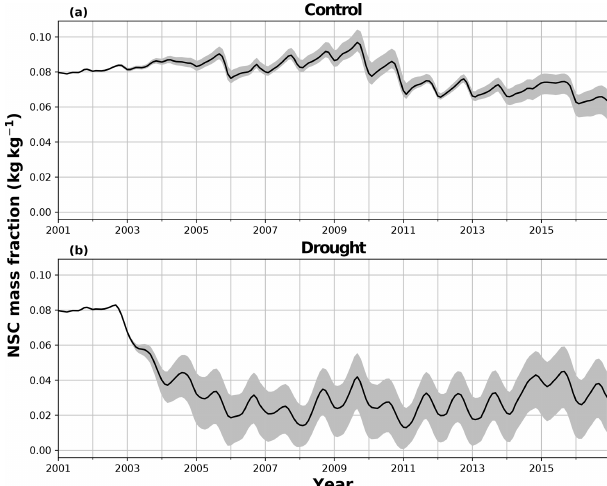
Figure 7. The effect of the parameter a K lated non-structural carbohydrate (NSC) as a fraction of total car- bon biomass in (a) the control plot and (b) the TFE plot. The mean, maximum and minimum from an ensemble of simulations where a K is varied between 0.1 and 2.0 are m